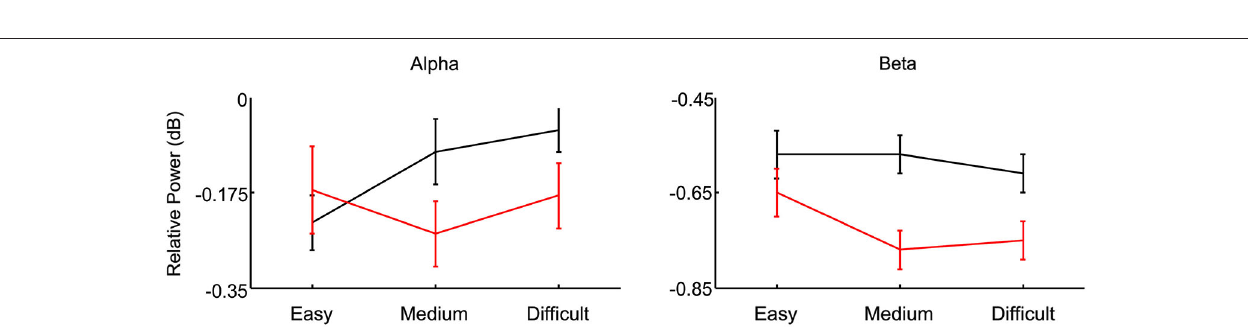
FIGURE 6 | Comparison between correct (black) and wrong (red) stop trials characterized by high (easy), medium or low (difficult) probability to inhibit the movement . The comparison is done separately for alpha and beta band.